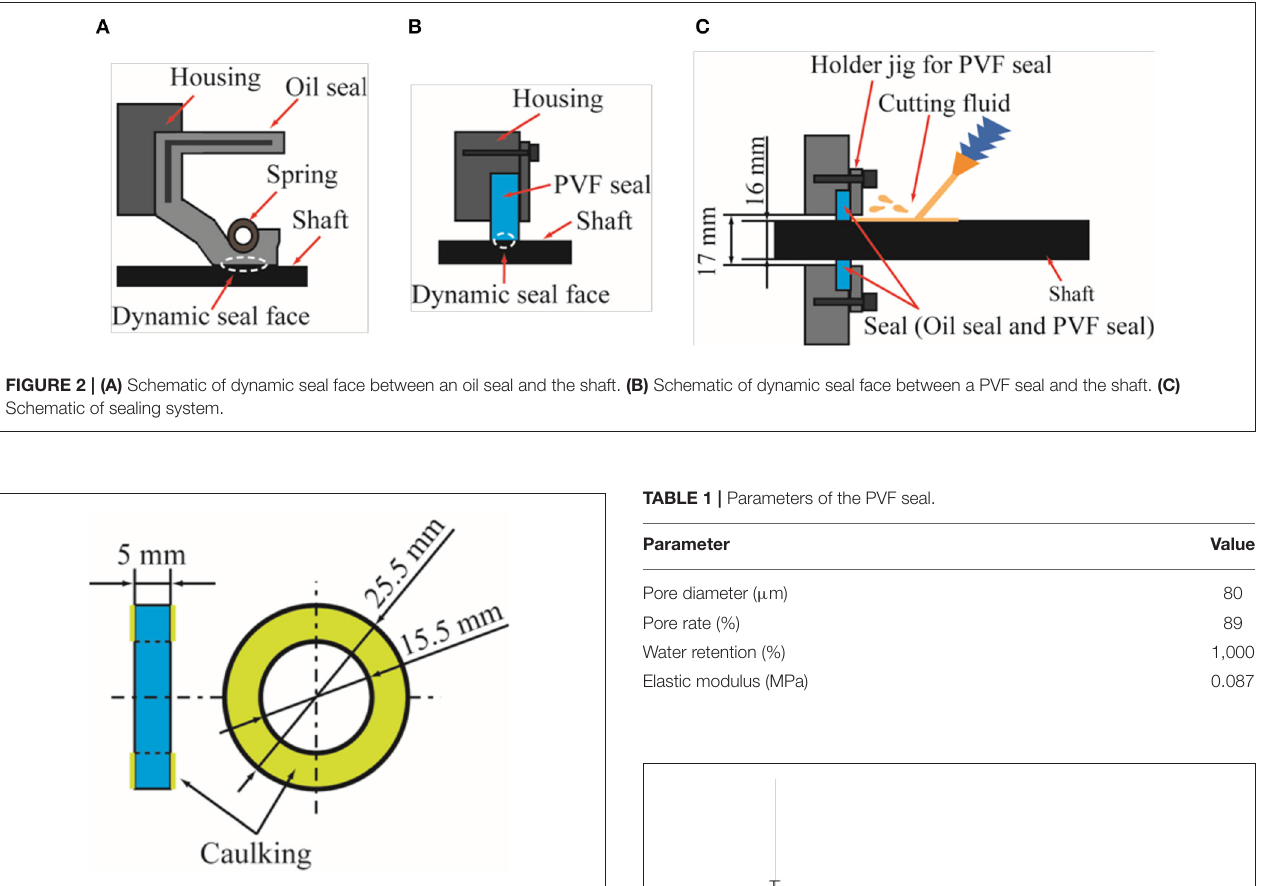
FIGURE 3 | Shape of the PVF seal.